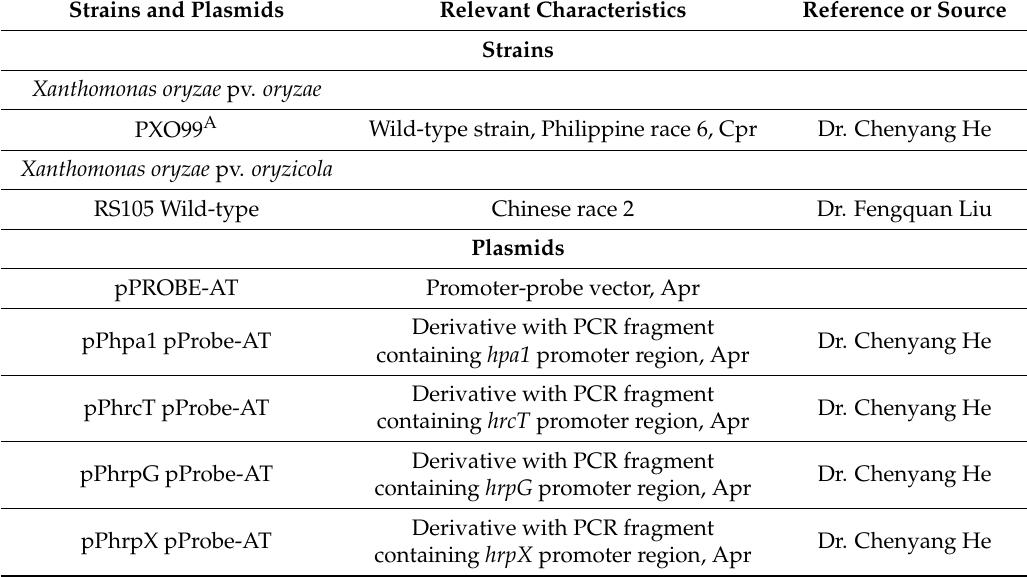
Table 2. Strains and plasmids used in this